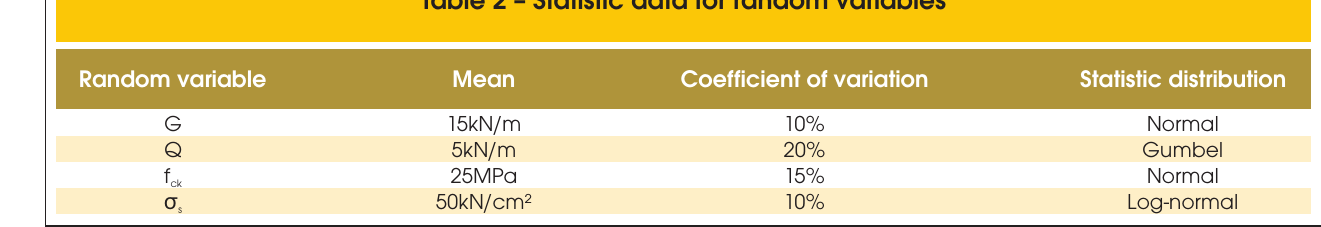
Table 2 – Statistic data for random